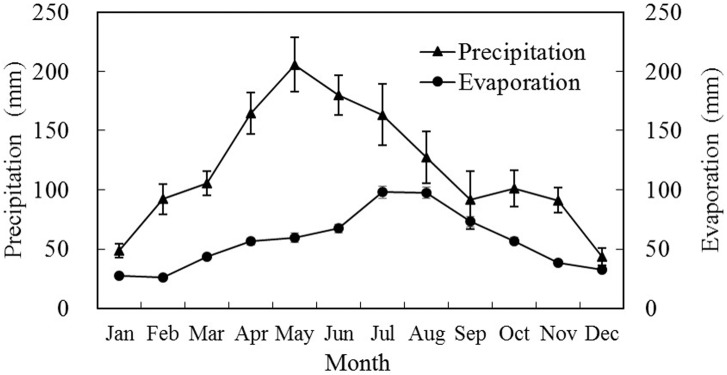
Monthly precipitation and evaporation in experimental site during 1998–2015.